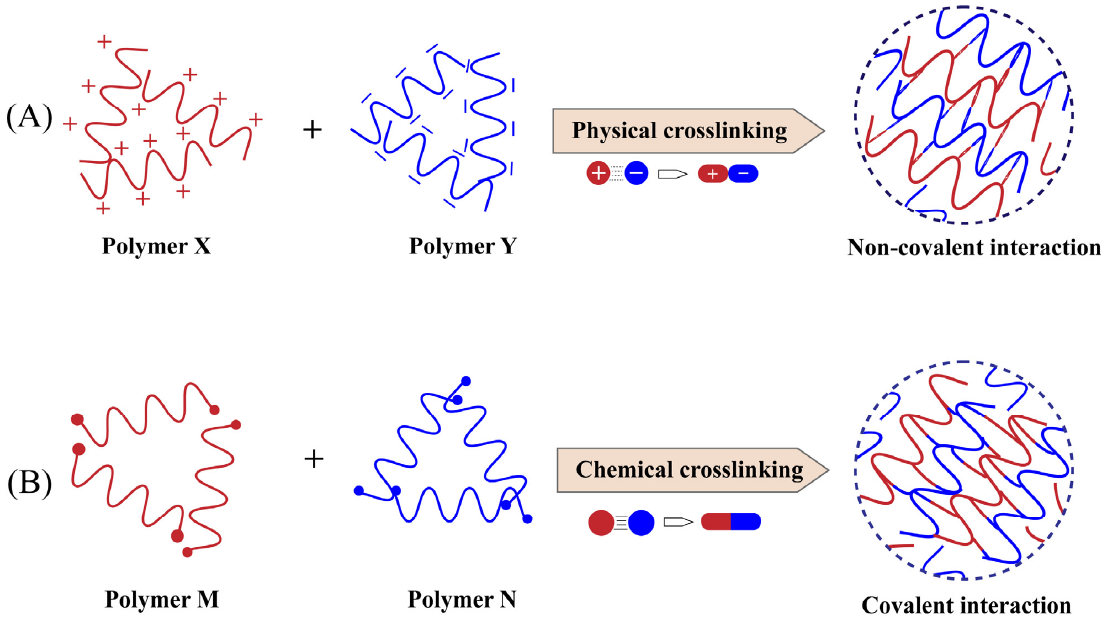
Figure 2. The preparation of nanogels is divided into two categories based on the type of bonds in the polymer network. ( A ) polymer X and polymer Y form physical crosslinked nanogels through noncovalent interactions, which are characterized by simple but unstable preparation; ( B ) polymer M and polymer N form chemically crosslinked nanogels through covalent interactions, which are characterized by stable structures but require safety considerations.